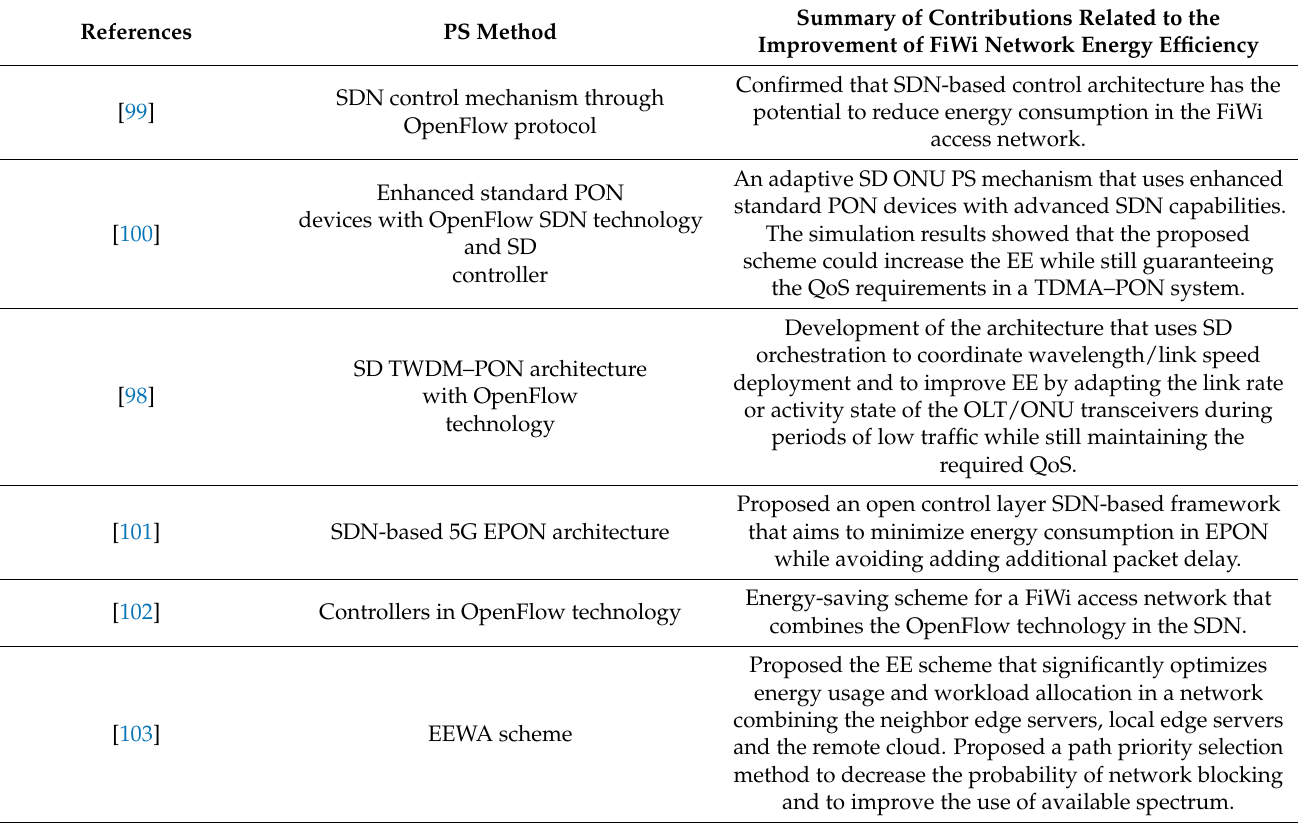
Table 5. Summary of the related works on PS methods in SDN-based